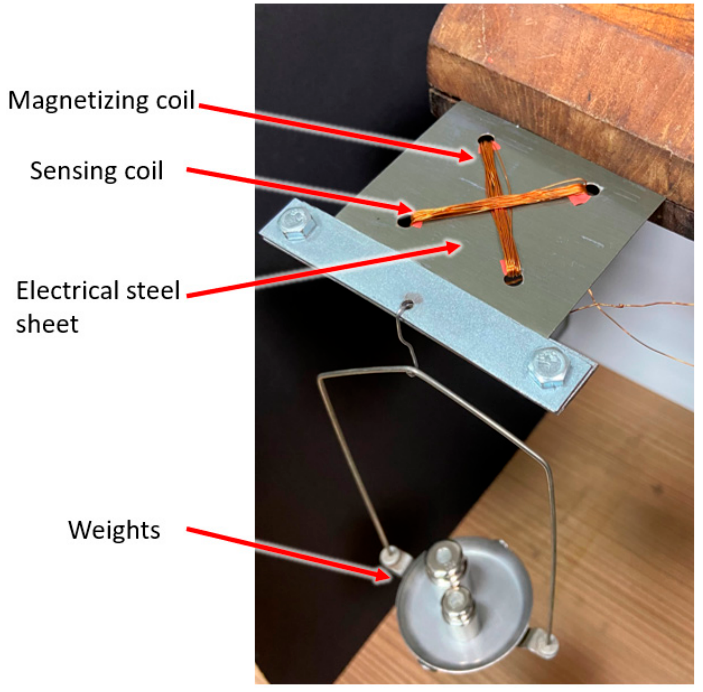
Figure 2. Force sensitive element—electrical steel sheet drilled and wound with orthogonal magnetizing and sensing windings in pressductor pattern.